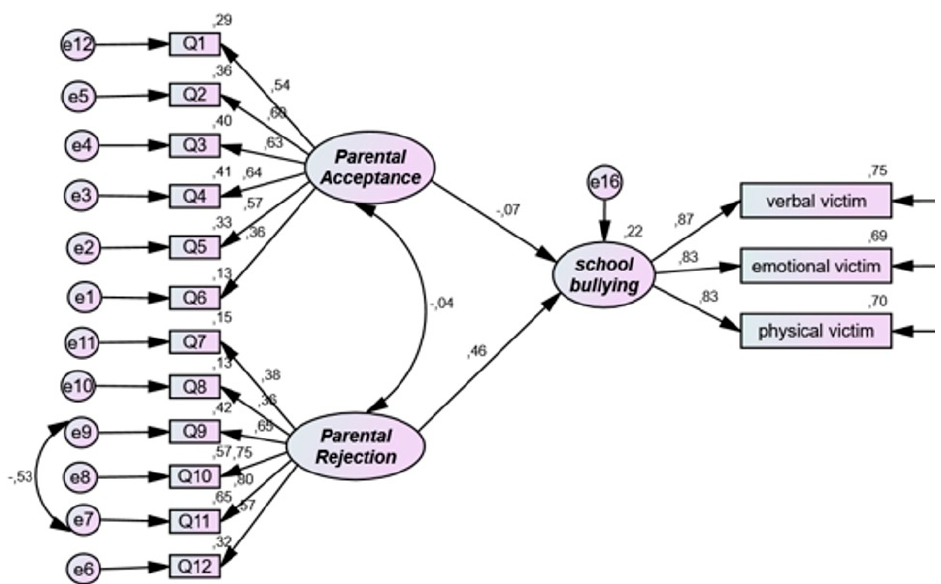
Figure 4. Structural model for research question 4. Note the structural equation modeling links between parental rejection of adolescents as an independent variable and school bullying as a dependent variable.